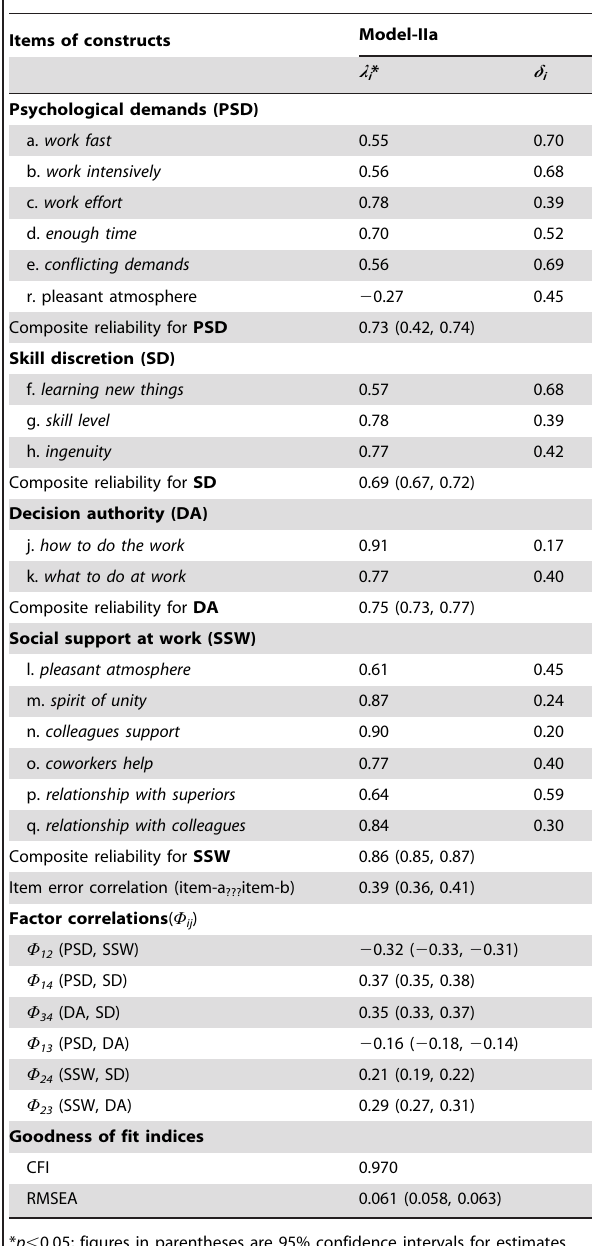
Table 3. Standardized loadings ( l i ), measurement errors ( d i ), factor correlations ( W ij ), composite reliability ( r cr ) and fit indices from validated model of the demand-control-support questionnaire based on